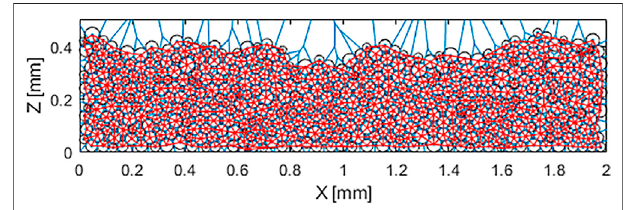
FIGURE 7 | Powder bed con fi guration including voronoi tessellation (blue) and network